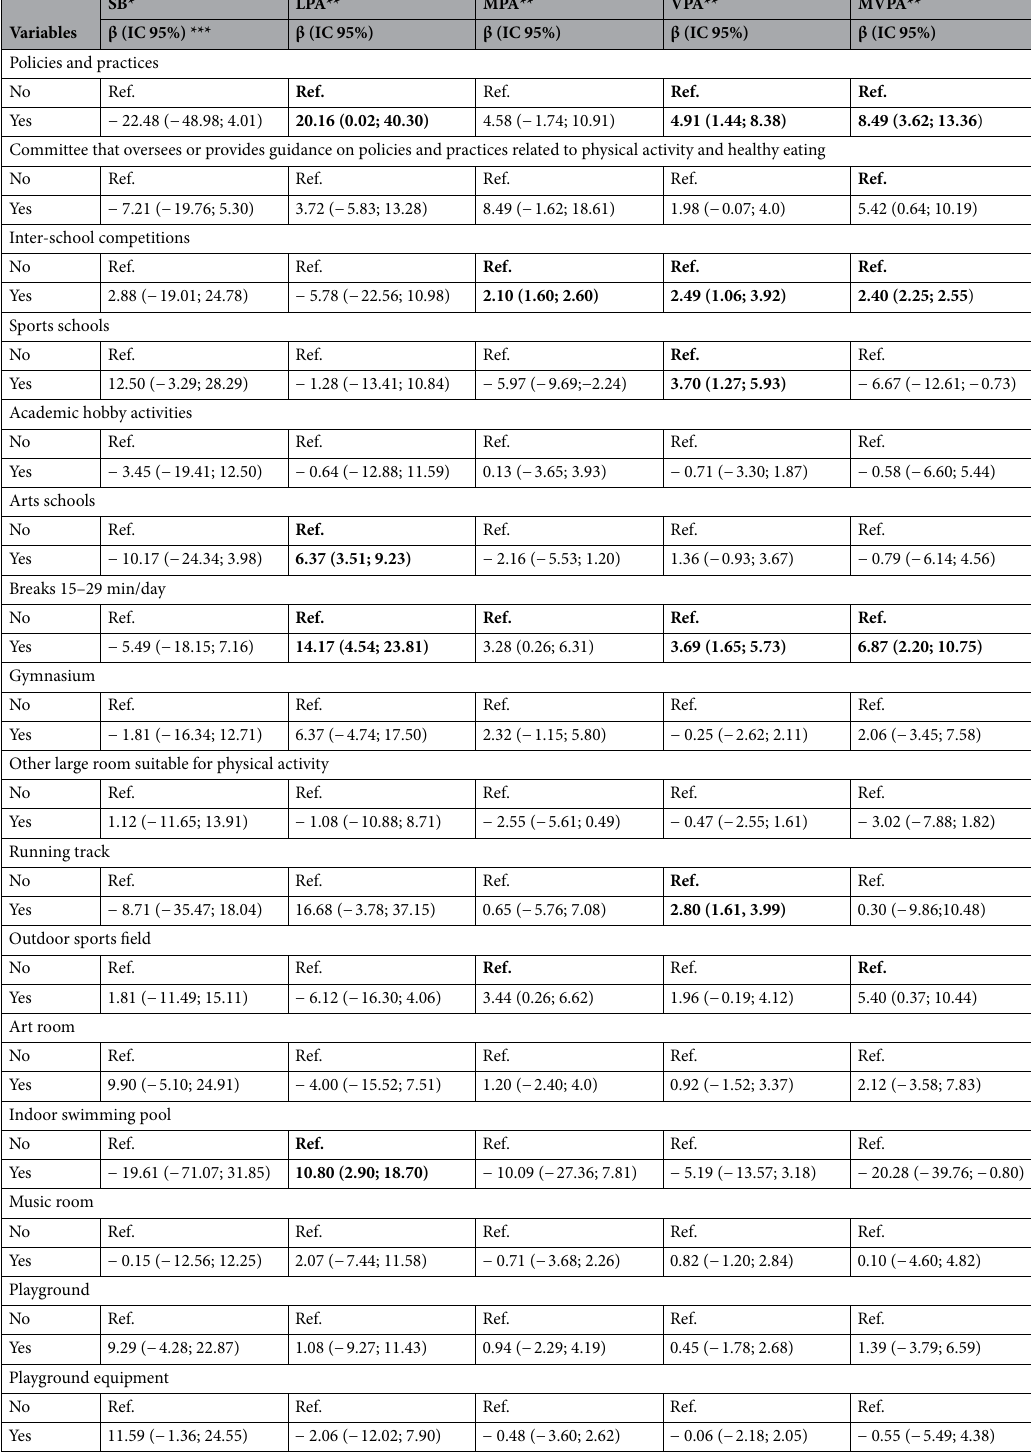
Table 4. Multilevel linear regression between school environment with sedentary behavior and physical activity intensities. Values in bold indicate significant associations. * SB sedentary behavior. **Intensities of physical